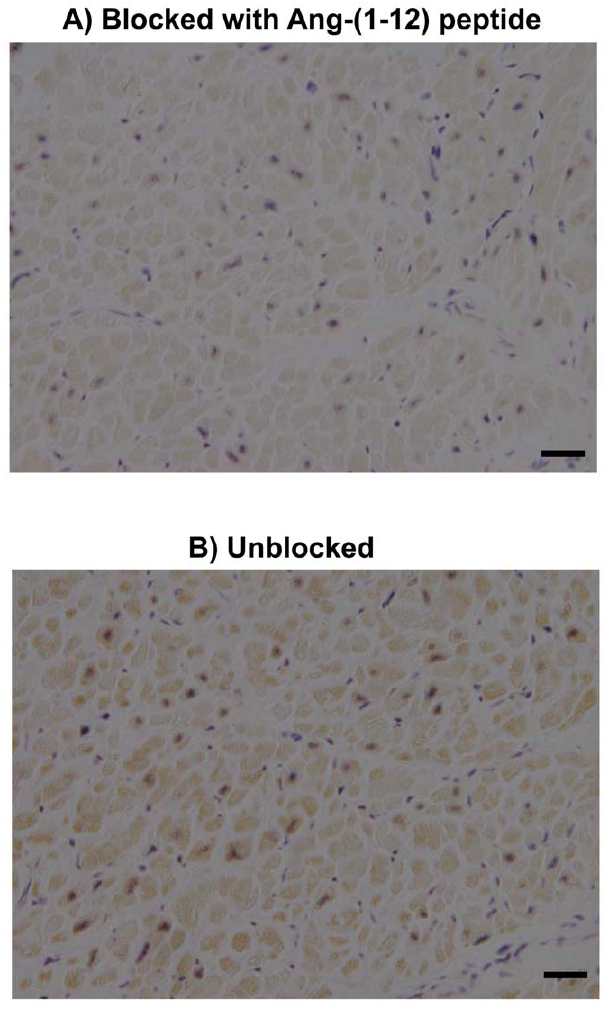
Figure 1. Localization of Ang-(1-12) in human atrial tissue. Comparative adjacent sections of Ang-(1-12) immunoreactivity ob- tained from human atrial tissue with protein A purified polyclonal antibody produced by AnaSpec. A) Antibody (1:2,000 dilution) blocked with 100 m mol/L of human Ang-(1-12) peptide, and B) Unblocked antibody (1:2,000 dilution). (Magnification 400; scale bar is 50 m m) .